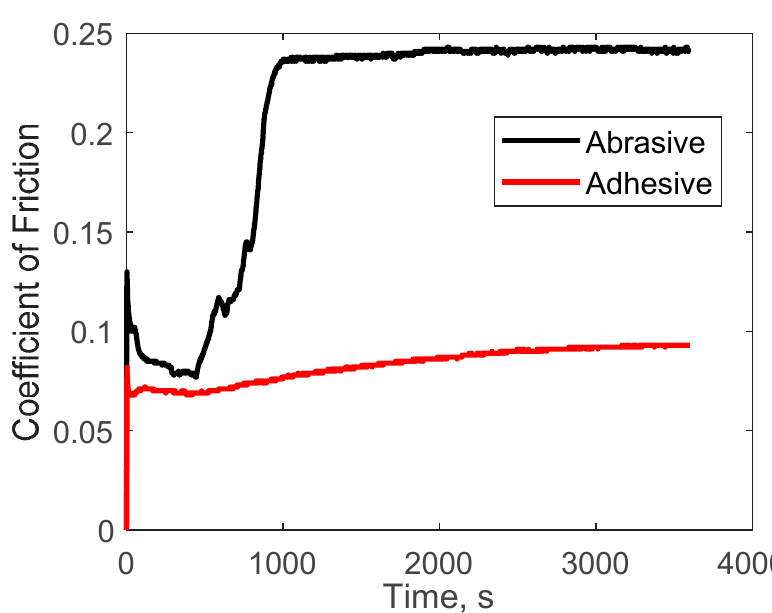
Figure 4. Coefficient of friction vs. time curves for adhesive (red) and abrasive (black) wear tests. These stages explain the three discernible sections in the plot of the cumulative